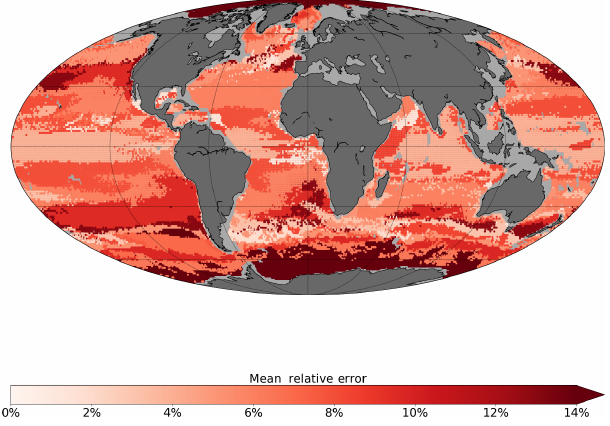
Figure 6. Averaged absolute value of relative error ( E r in %, Eq. 9) between the estimated and the target energy transfer parameters ( E (cid:48) ) according to the location of the chosen observation points, as- i sociated with the forcing fields described in Sect. 2.1. Cells with no data have been shaded in